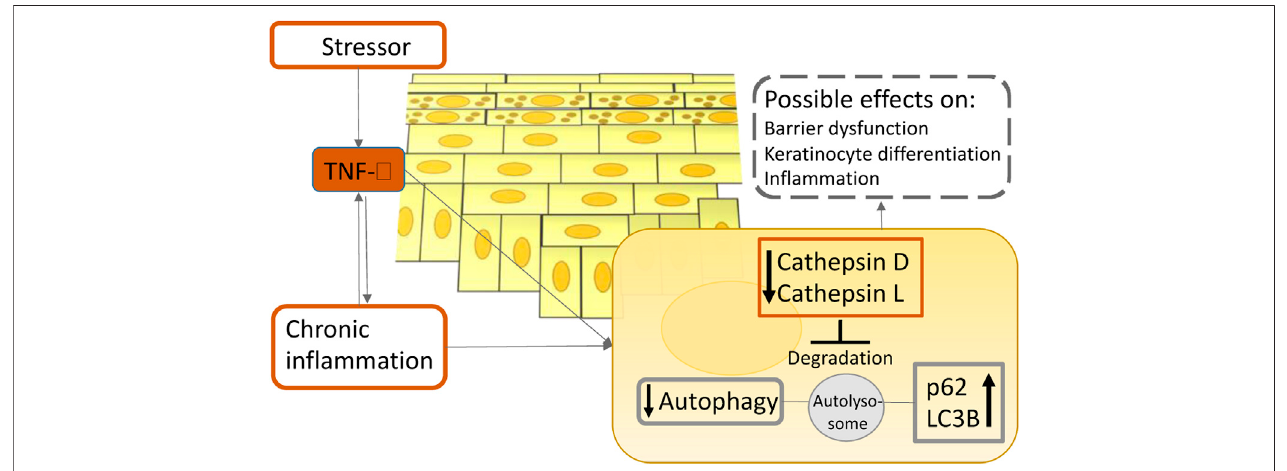
FIGURE 4 | A simpli fi ed scheme illustrates the role of TNF- α on autophagy in atopic dermatitis and psoriasis pathogenesis. Upon in fl ammation in the epidermis, TNF- α reduces the enzymatic activity of lysosomal cathepsins, leading to lysosomal dysfunction which ultimately results in autophagy suppression. This process could contribute to the chronicity of cutaneous in fl ammatory